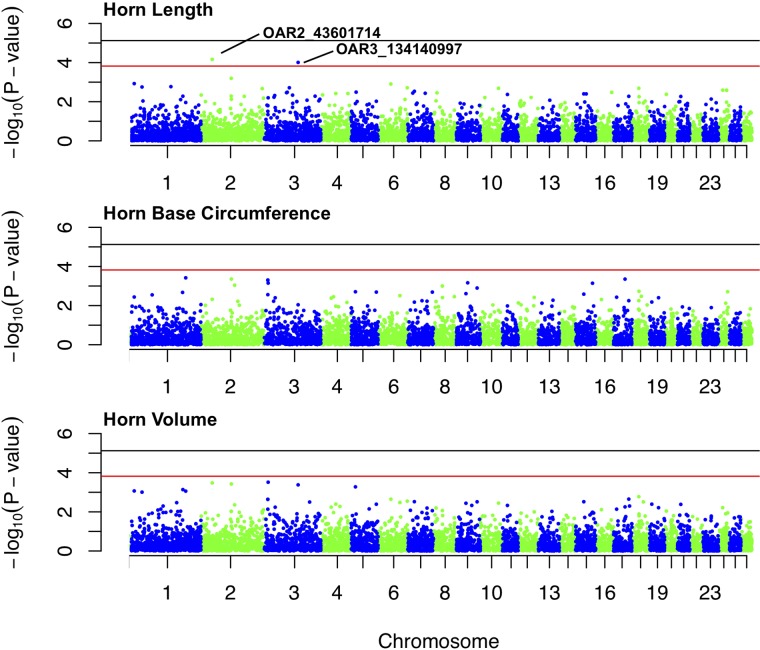
Manhattan plots for associations between SNPs and each of three horn size traits: horn length, horn base circumference, and horn volume. The black line represents the threshold for genome-wide significance, and red line represents suggestive significance. The two labeled loci are of suggestive significance for horn length.